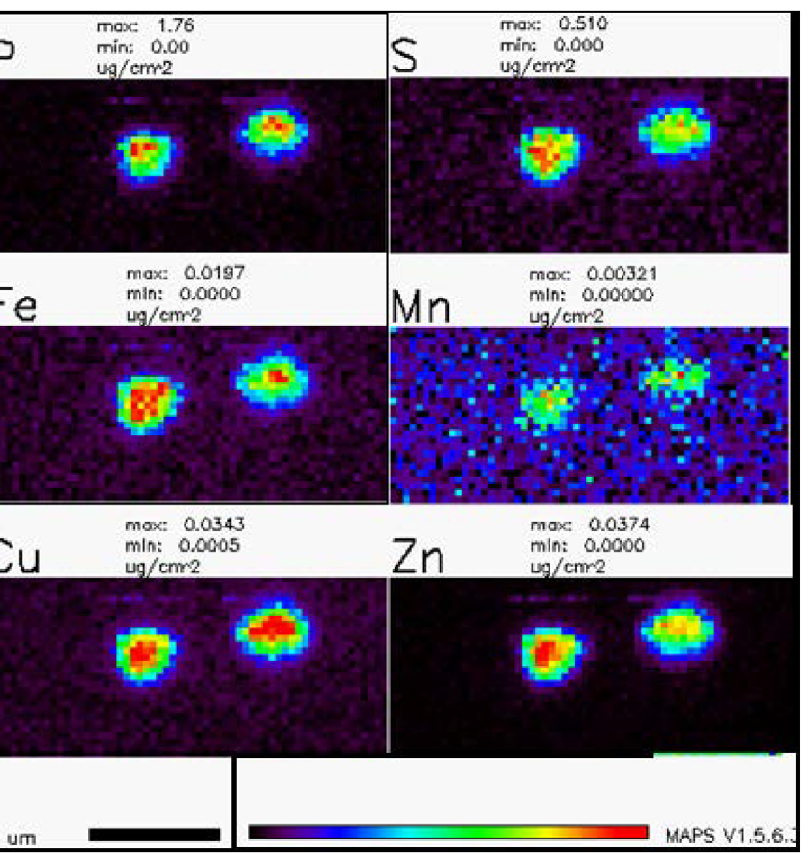
Figure 1. Spatial profiles of several elements in two N.europaea cells in close proximity at stationary phase and not exposed to Cu(II), quantified using MAPS software [ 33 ] . Dark colors represent lower concentrations and lighter colors represent higher concentrations.